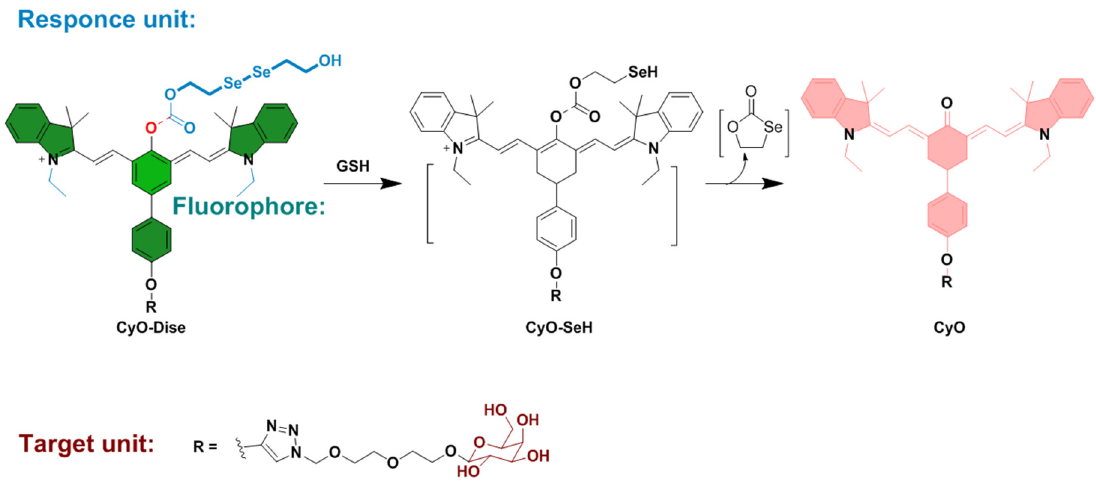
Figure 39. Structure of fluorophore based on hemicyanine synthesized by Han et al.